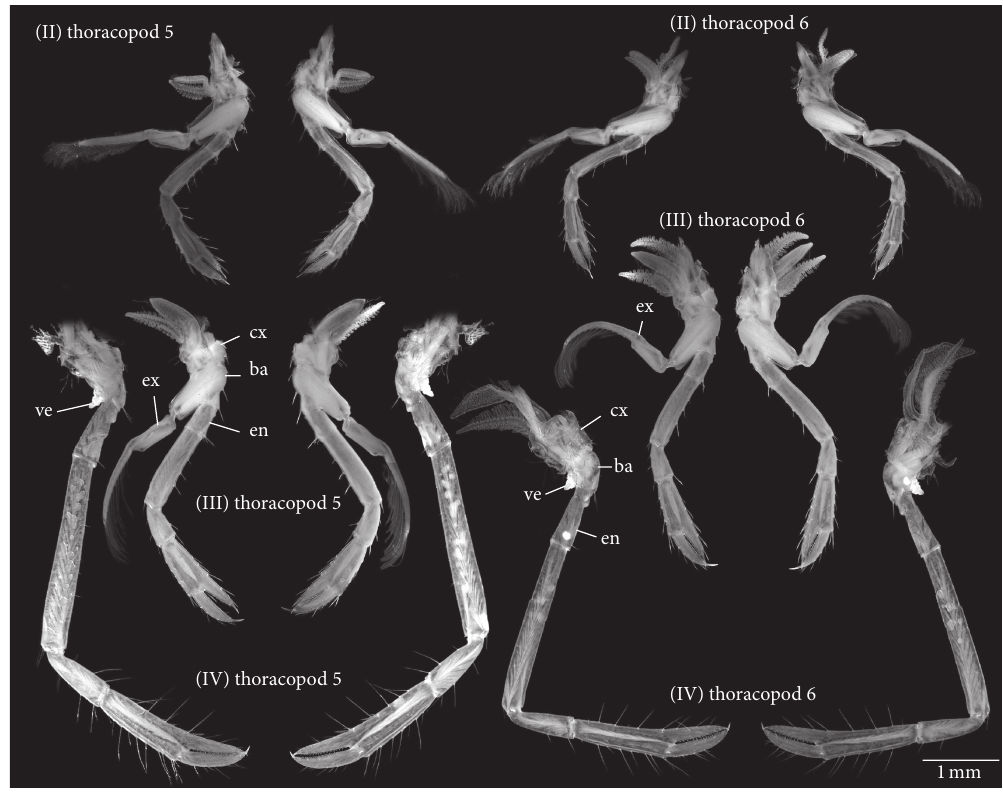
Figure 8: Thoracopods 5 and 6 of larval stages (II) to (IV) of Homarus gammarus . Right appendage in anterior (left) and posterior (right) view, besides (IV) thoracopod 5, (III) thoracopod 6, and (IV) thoracopod 6, which are left ones flipped. Labeling only given in one instance due to the similarity of the structures throughout all stages. ba = basipod; cx = coxa; en = endopod; ex = exopod; ve = vestigial